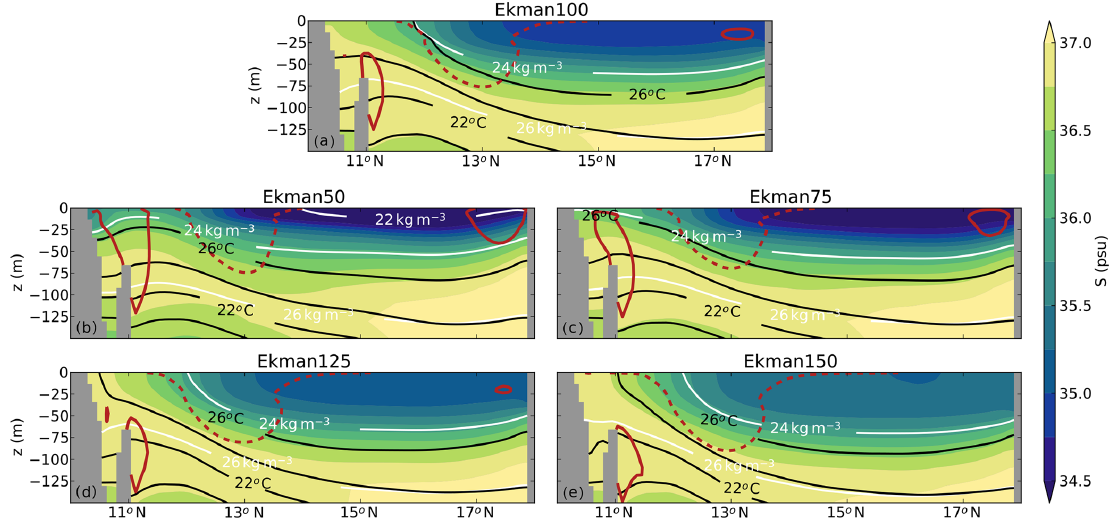
Figure 10. Cross section at 66 ◦ W of the 20-year averaged salinity in (a) Ekman100, (b) Ekman50, (c) Ekman75, (d) Ekman125, and (e) Ekman150 (shading). The solid red line indicates the position of the subsurface countercurrent (contour line at an eastward velocity of 0.07ms − 1 ). The Caribbean Current is indicated with the dashed red line (contour line at a westward velocity of 0.2ms − 1 ). The black contour shows the 20-year average temperature in each simulation; the white contour indicates the 20-year average density in each